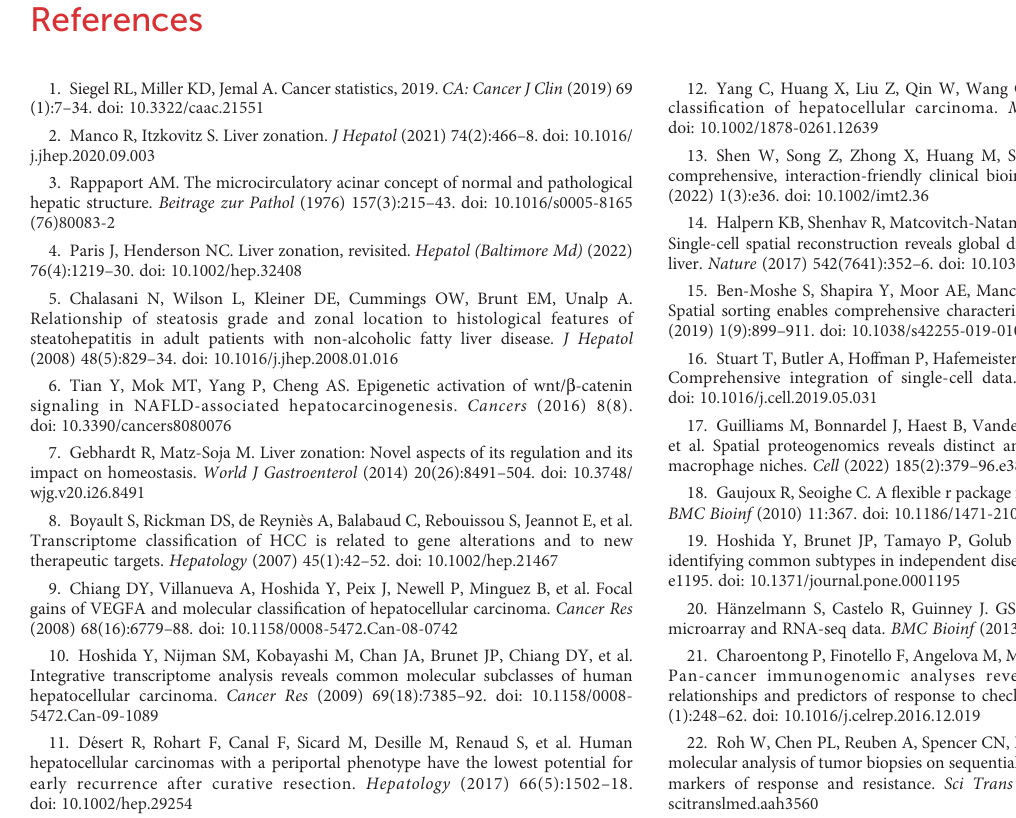
clustering. (A) Heatmap plot shows the consensus matrix of NMF clustering results using the gene expression data of 94 zonation markers in the microarray cohort (GSE14520+E-TABM-36), colored by three HCC subclasses (Cluster1, Cluster2, and Cluster3). (B) Heatmap plot shows the expression pattern of the zonation markers of the three clusters. (C) The difference of the GSVA scores of the portal and central signatures among the three clusters. Comparison between central and portal by Student ’ s t-test; Comparison among three clusters by ANOVA -Tukey test. (D) The SubMap matrix shows a signi fi cant correlation between HCC classi fi cation from RNA- seq and microarray cohorts. GSVA: Gene set variation analysis. SUPPLEMENTARY FIGURE 3 Clinical characteristics of zonation marker associated HCC subclasses in the microarray cohort. (A) Difference of clinical characteristics among the three clusters in microarray cohort by chi-square test (The comparison of survival time among the three clusters by ANOVA). (B) Correlation of the three clusters